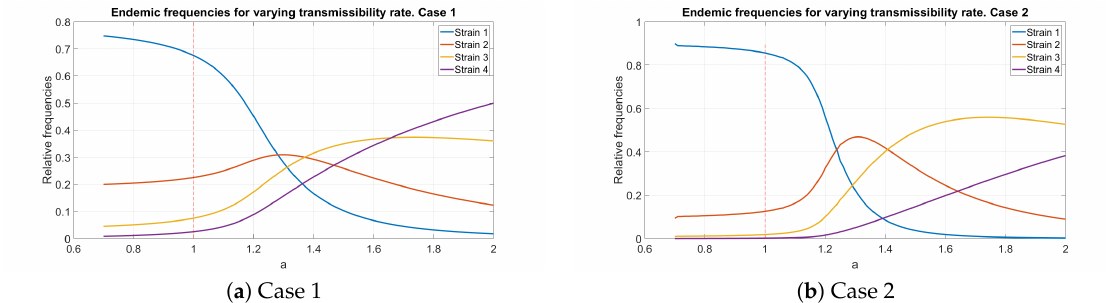
Figure 2. The relative endemic distribution of infected individuals for different values of the transmissibility rate of the 4th strain, parametrized with a : β C ,4 = a β C . The values at a = 1 (marked by a red dashed line) correspond to the baseline case, where all transmissibility rates are equal. Subfigures ( a ) and ( b ) correspond to different values of mutation probabilities π i